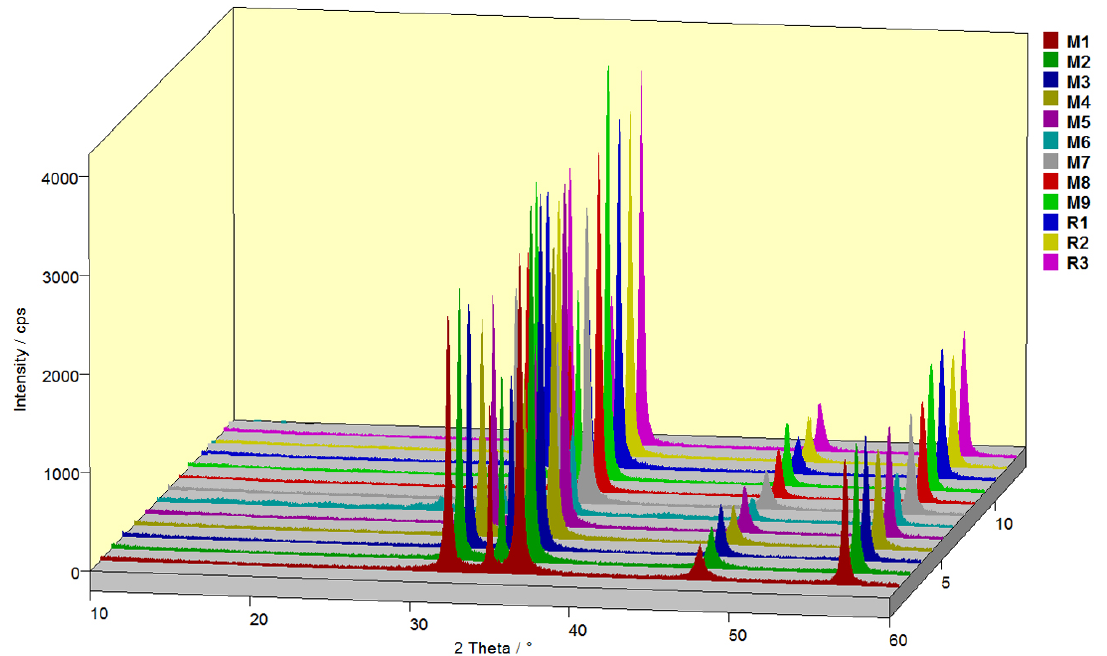
Fig. 2. XRD diffractogram of all